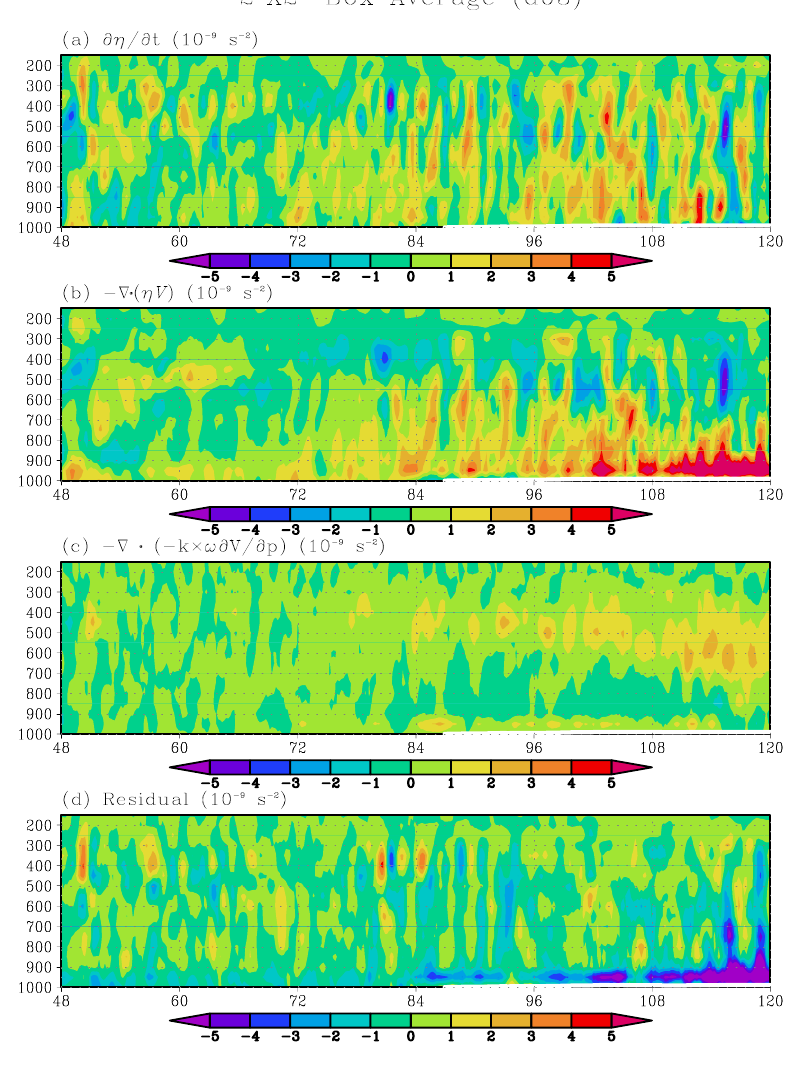
Fig. 17. Vorticity budget (averaged over a 2-degree × 2-degree box following the pouch center) from Hour 48 to Hour 120. All fields are derived from the inner most grid (d03) simulation and a one-hour running mean was applied to reduce high-frequency fluctuations. The vorticity tendency units are 10 − 9 s − 2 . The ordinate is pressure (hPa) and the abscissa is time (h).